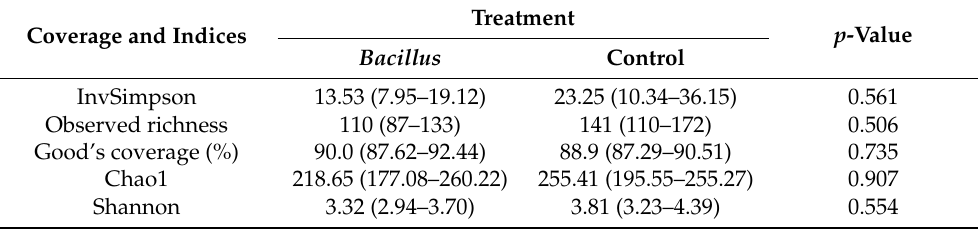
Table 4. Coverage and alpha diversity of epiphytic bacterial communities from lettuce leaf samples grown in Bacillus -treated and control systems. Mean values are followed by the standard error of the mean and the range is given in parentheses. No significant effect of Bacillus probiotic treatment on alpha diversity and coverage was observed ( t -test, p >